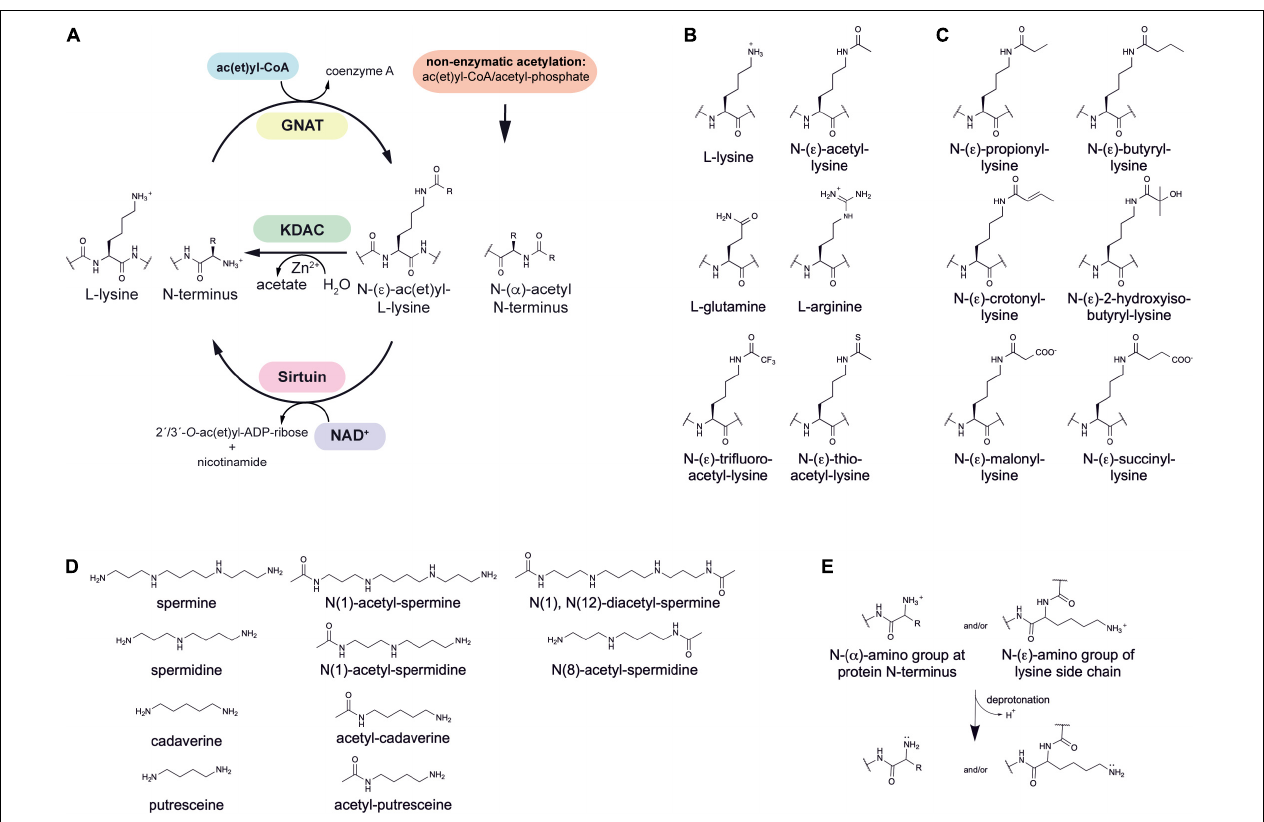
FIGURE 1 | Post-translational lysine ac(et)ylation is dynamically regulated by lysine deac(et)ylases and N-( α )-/N-( ε )-ac(et)yltransferases. (A) The ε -amino group of lysine side chains and the α -amino group at the protein N-termini can be ac(et)ylated by lysine acetyltransferases (KATs) using acetyl-CoA and/or further acyl-CoA donor molecules for the ac(et)ylation. So far, all bacterial protein acetyltransferases belong to the Gcn5-related N-terminal acetyltransferases (GNAT). Next to the enzymatic ac(et)ylation, lysine side chains and protein N-termini can ac(et)ylated non-enzymatically by ac(et)yl-CoA and acetyl-phosphate, the major source for non-enzymatic acetylation in bacteria. Bacteria use Zn 2 + -dependent classical lysine deac(et)ylases and NAD + -dependent sirtuin deac(et)ylases to catalyze the deac(et)ylation of lysine side chains. (B) Structures of amino acids used to study lysine acetylation. L-glutamine is often used to mimic lysine acetylation and L-arginine to conserve a non-acetylated state in studies performed in vivo . Trifluoroacetyl-L-lysine and thioacetyl-L-lysine are used as mechanistic inhibitors for sirtuins to stabilize the acetylation at an analyzed site. Notably, these analogs can be potently deacetylated by some classical deacetylases. (C) Diverse acylations identified to occur at lysine side chains in bacteria. Lysine side chains can be modified by various aliphatic or negatively charged acylations in bacteria. Further acylations might be discovered in future. To which extend acetyltransferases are capable to catalyze acylation of the lysine side chains and/or protein N-termini needs further investigation. In general, all acyl-CoA thioesters generated in metabolism can be transferred to the ε -amino group of lysine side chains and/or the α -amino group at the protein N-termini in terms of an non-enzymatic reaction. (D) Polyamines in bacteria shown to be acetylated by acetyltransferases and deacetylated by classical deacetylases. These polyamines might form buffers for acetyl-groups to avoid systemic non-enzymatic protein acetylation. The acetyl-groups can be transferred from acetyl-CoA by the action of polyamine specific acetyltransferases. (E) Increasing the reactivity at the N-( ε )-amino group